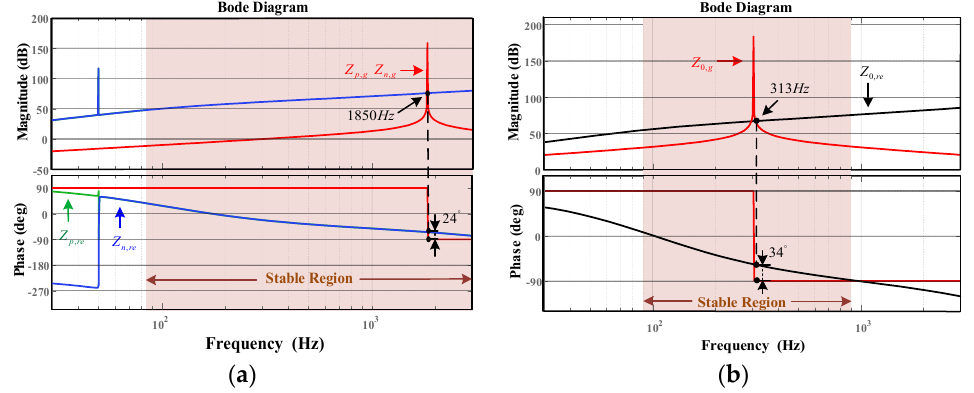
Figure 12. Bode diagram for the reshaped impedance of LCL-TFSCI and the grid with parallel compensation capacitors. ( a ) Positive-sequence and negative-sequence; ( b ) Zero-sequence.